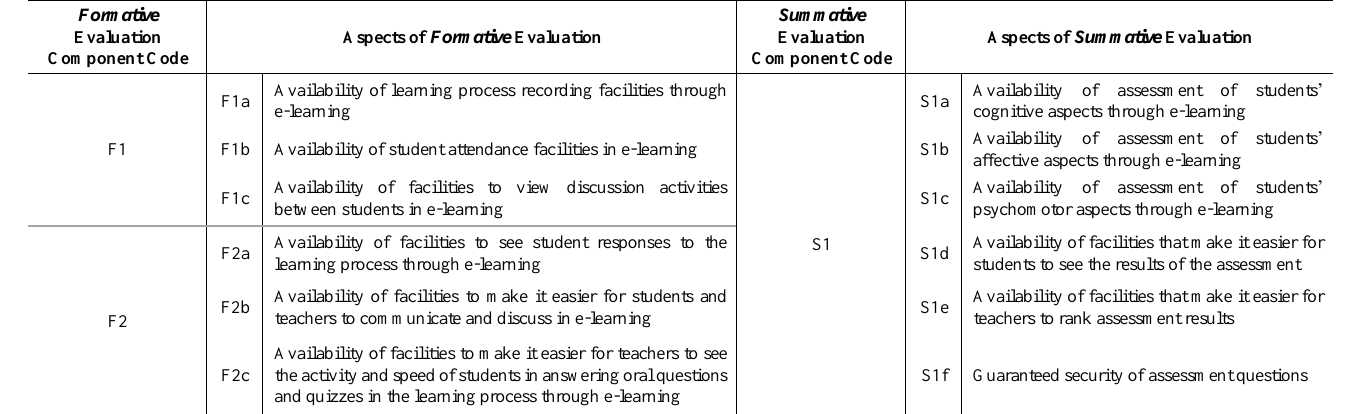
Table 3. Aspects of Formative-Summative Evaluation Based on Tri